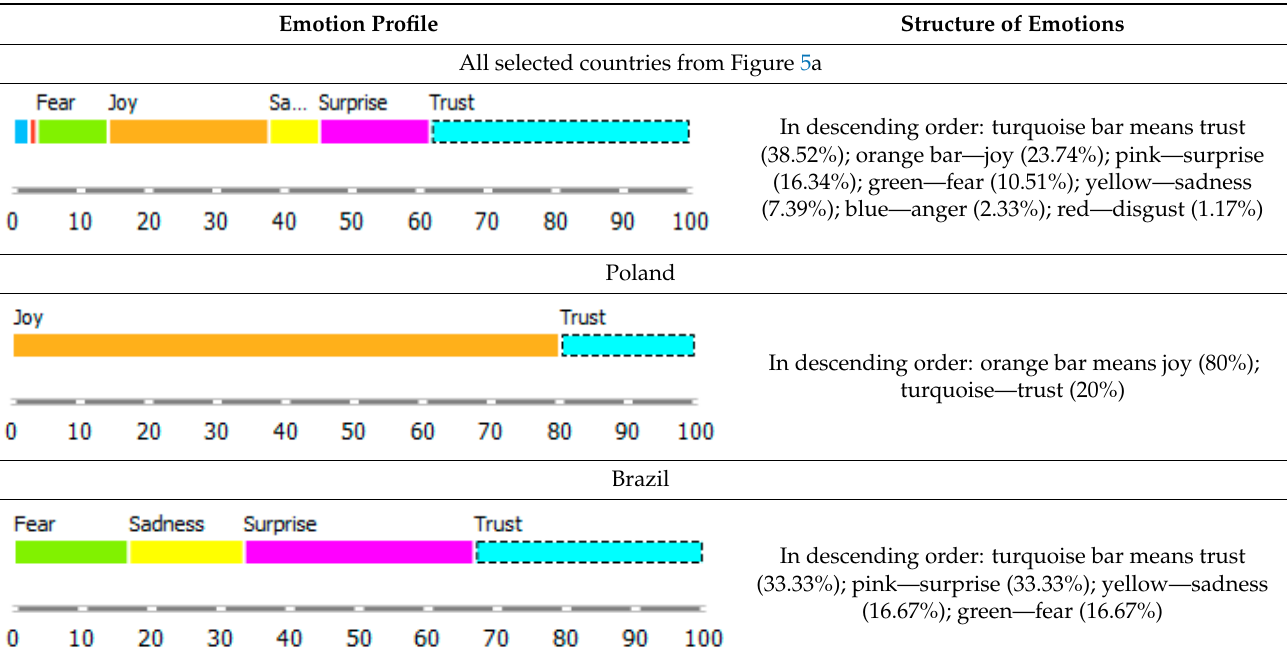
Table 3. Emotion recognition in publications with a selection of country.